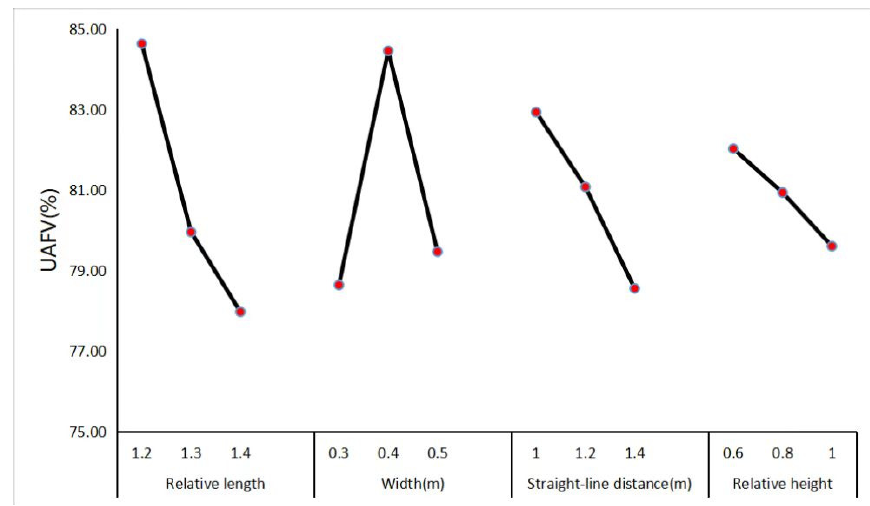
Figure 6. The trend of UAFV with three levels for each factor. The trend diagram of CWAAFV is shown in Figure 7. When the relative length reaches 1.3 or the width of the diversion pier is 0.3 m or the length of the straight-line segment at the tail is 1.0 m or the relative height of the diversion pier is 0.6 m, CWAAFV values are